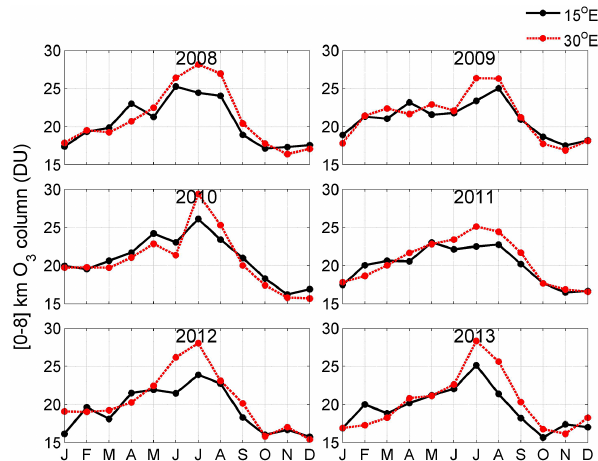
Figure 5. Six-year monthly variation of the integrated [0–8]km IASI O 3 column averaged over [30–45 ◦ N] at 15 ◦ E (in black) and 30 ◦ E (in red). Higher summer values are observed to the east of the basin at 30 ◦